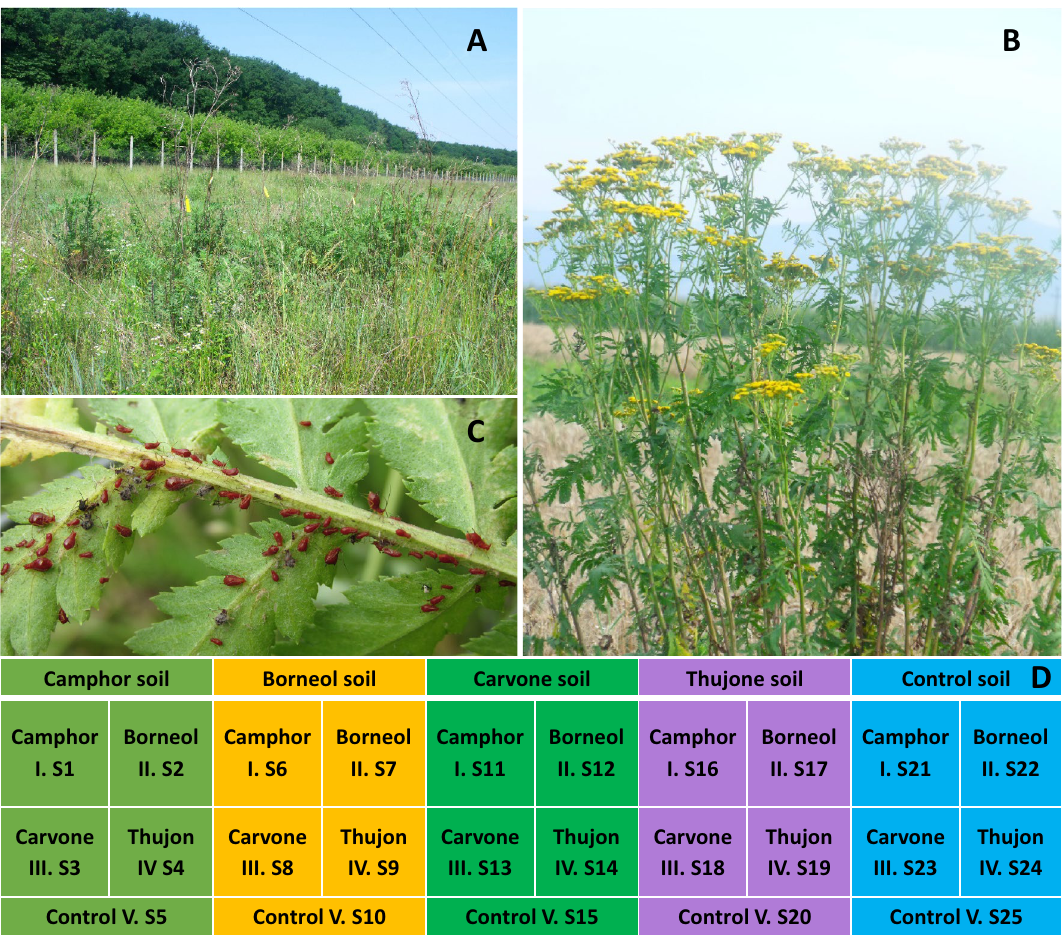
Figure 1. Tansy field ( A ), Tansy plant ( B ), U. tanaceti aphids on tansy leaves ( C ) (Photos made by Adalbert Balog), litter decomposition and soil bacterial community assay design ( D ). Numbers represents sample orders, which were used consequently in labelling samples for genetic analyses. The first four treatments representing the main chemotype soils (I, II, III, IV), the control with no tansy (V) soil were used in boxes, within each, litter additions from the different chemotypes (I-IV) or non-Tansy plants (V) were placed. Marks as S1… S25 represents particular chemotype samples in particular chemotype soil (i.e. III.S3 means Carvone litter in Camphor soil, versus III S8 Carvone litter in Borneol